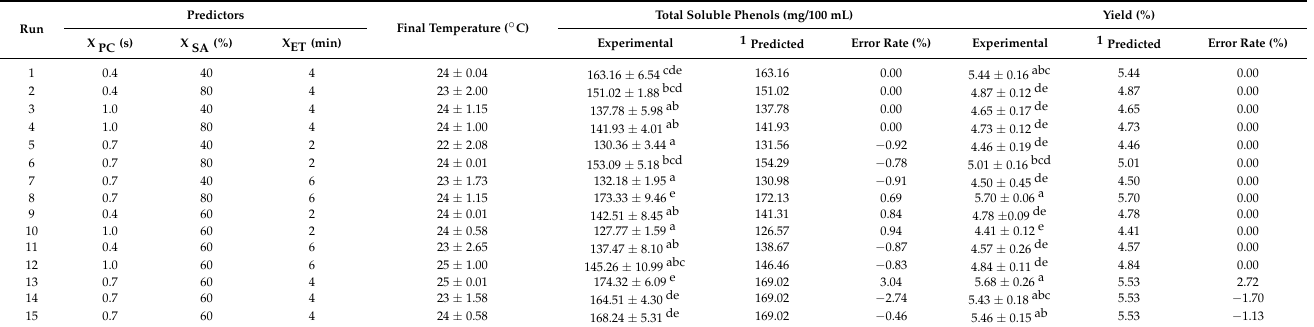
Table 1. Experimental values of total soluble phenols and yield after ultrasonic-assisted (Box-Behnken design) from extracts of Annona muricata leaves also showed predicted values and error rates after the response surface